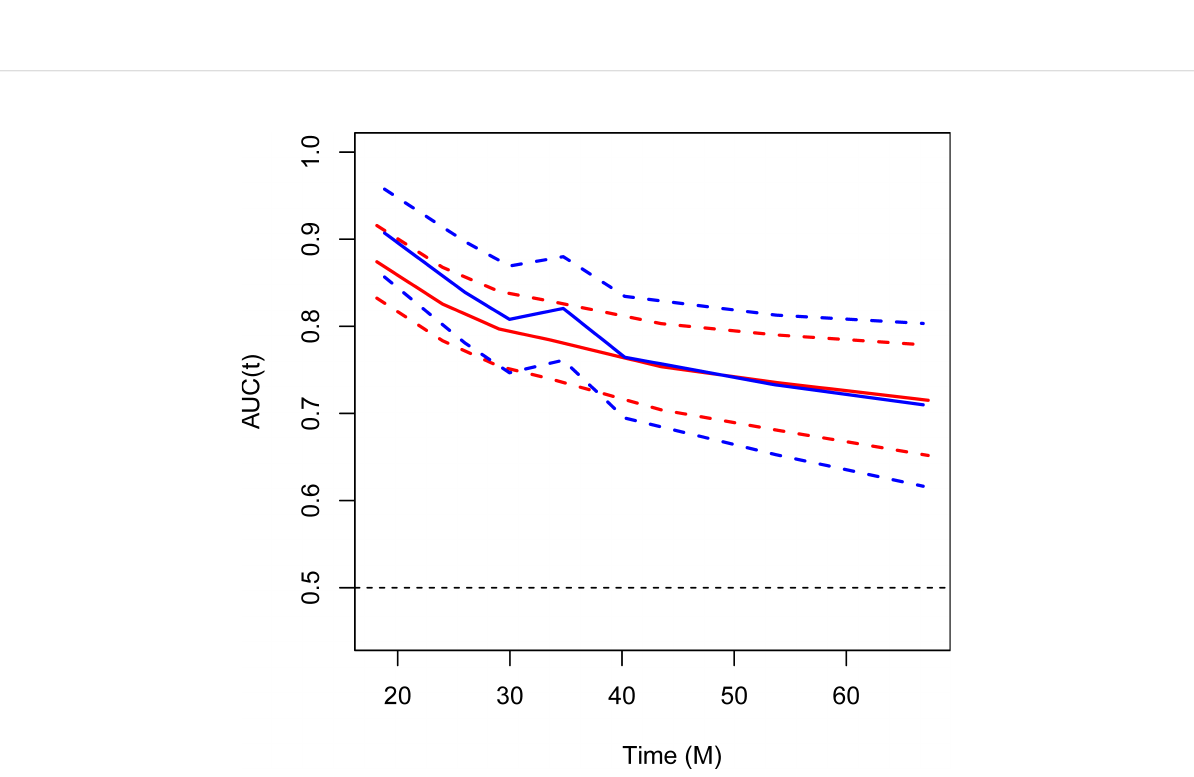
FIGURE 4 Area under the receiver operating characteristic (ROC) curve (AUC) for assessing predictive accuracy of the nomogram for OS. Red, training cohort; blue, validation